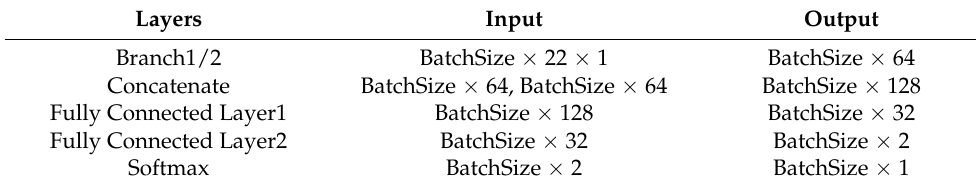
Table 3. The input and output dimensions of each layer in the DB-BiLSTM. BatchSize = 64.